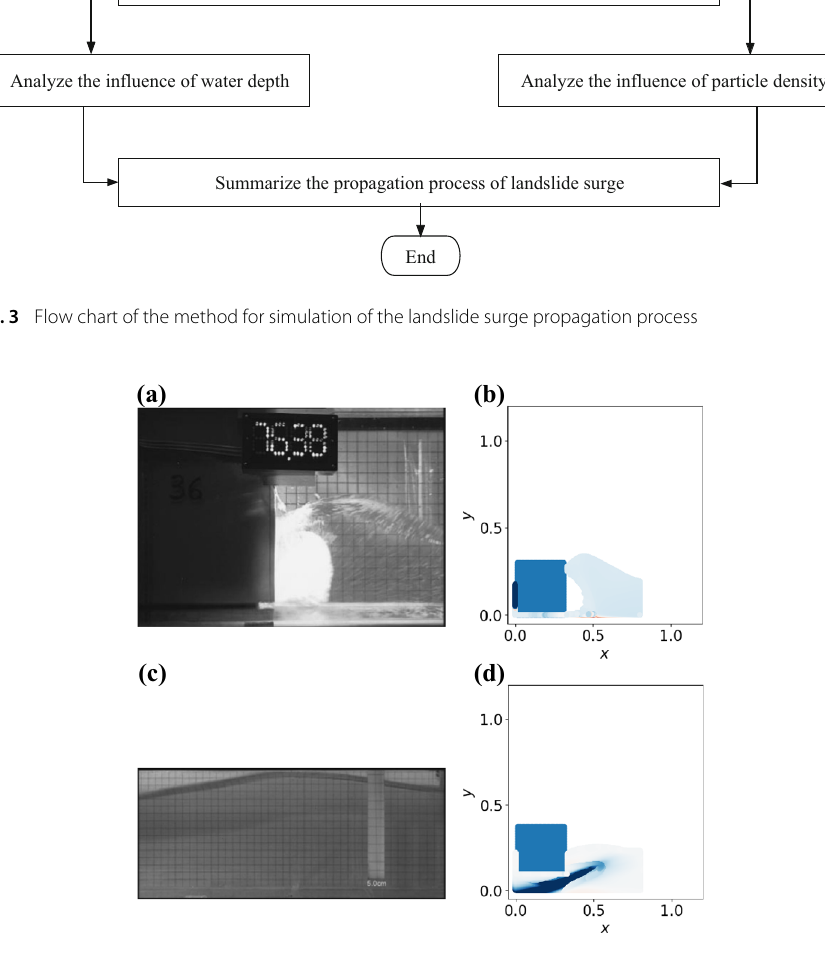
Fig. 4 Comparison between simulation results of landslide surge propagation process based on PINN and physical experiment results [27] (D=0.21 m,